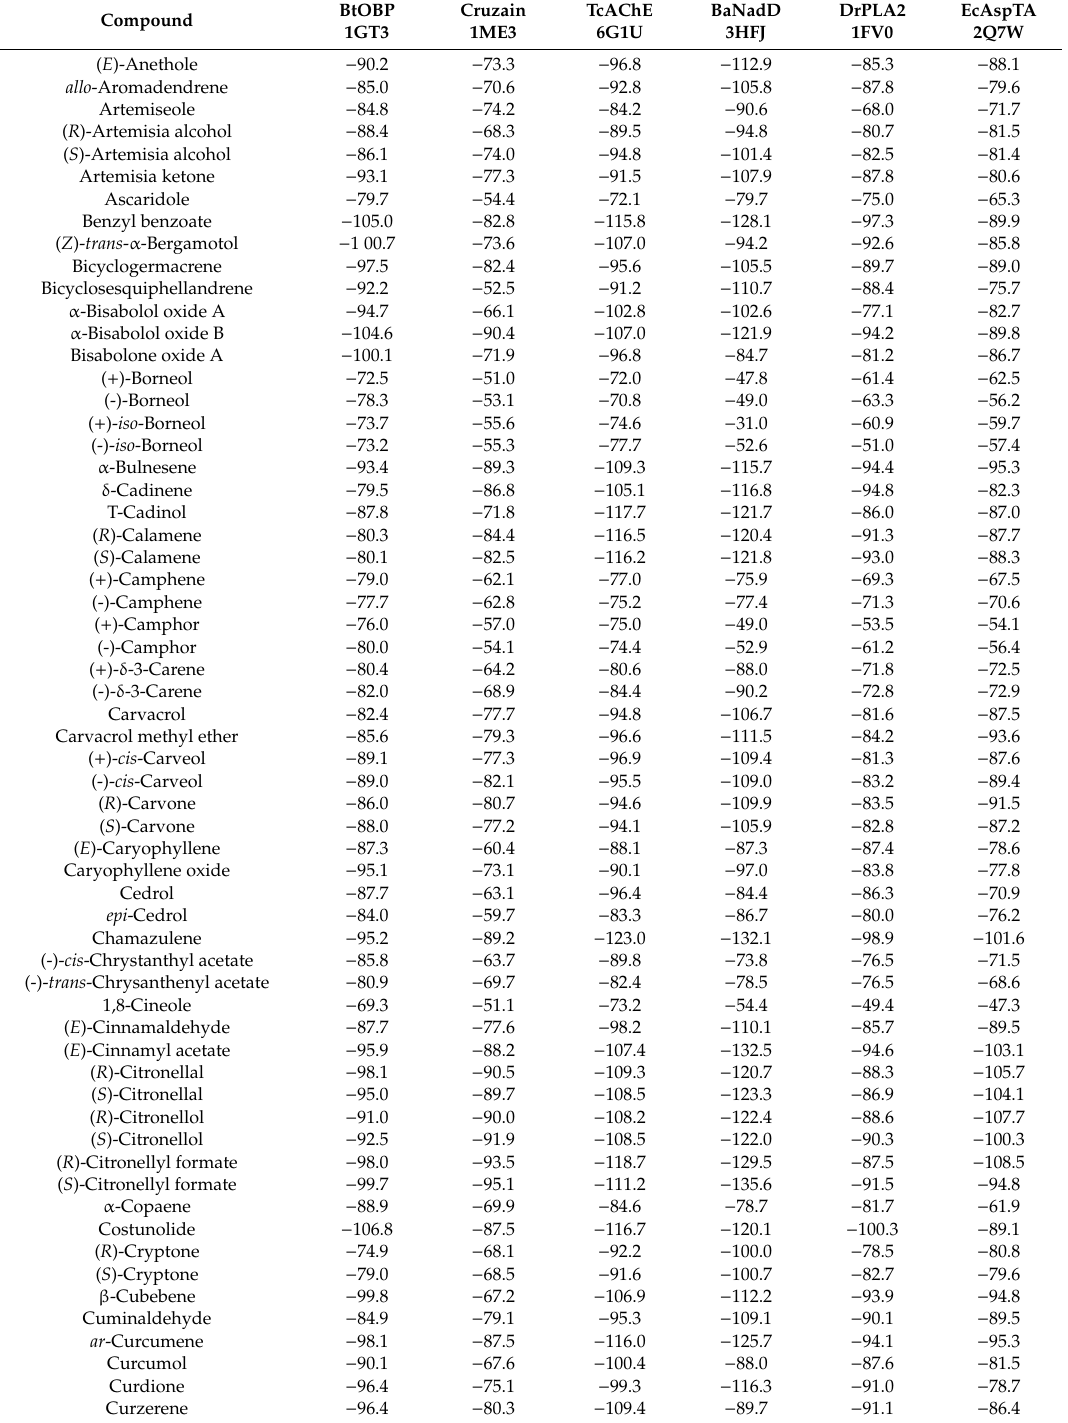
Table 4. Normalized docking scores ( DS norm , kJ / mol) of essential oil components with bovine odorant binding protein (BtOBP), cruzain, torpedo acetylcholinesterase (TcAChE), Bacillus anthracis nicotinate mononucleotide adenylytransferase (BaNadD), Russell’s viper phospholipase A 2 (DrPLA2), and Escherichia coli l -aspartate aminotransferase (EcAspTA). Compound